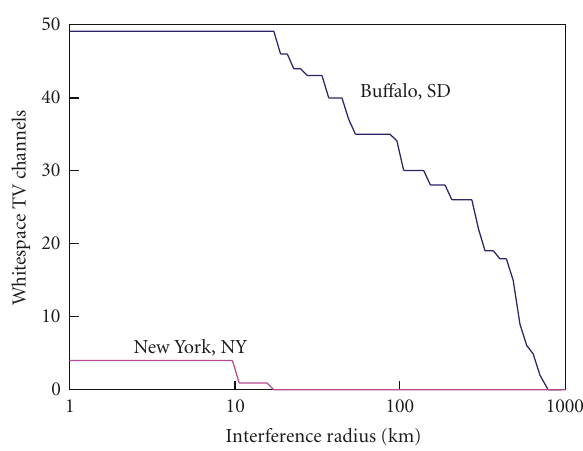
Figure 1: The number of 6MHz TV channels available for cognitive radio use as a function of potential interference. Computed for New York City (Times Square) and Bu ff alo County, SD (geographic